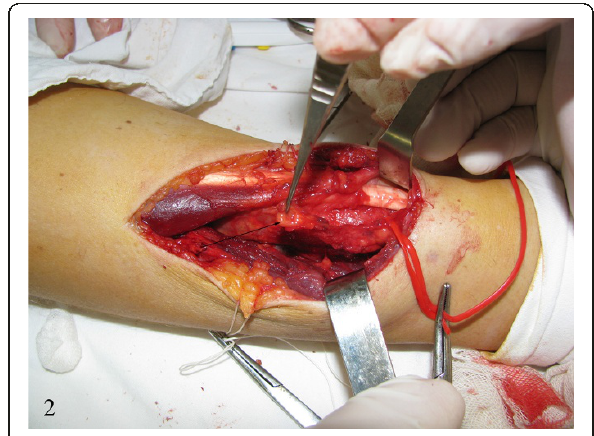
Figure 2 Intraoperative detail . EHE isolation from the forearm extensor compartment muscles, tumor invasion into adjacent radius being confirmed